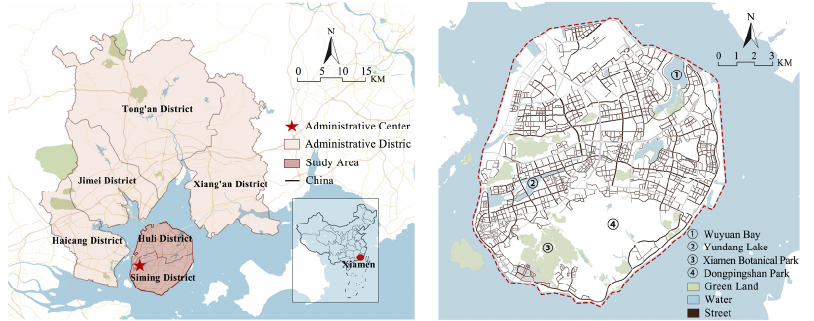
Figure 5. Location and street distribution of Xiamen Island.